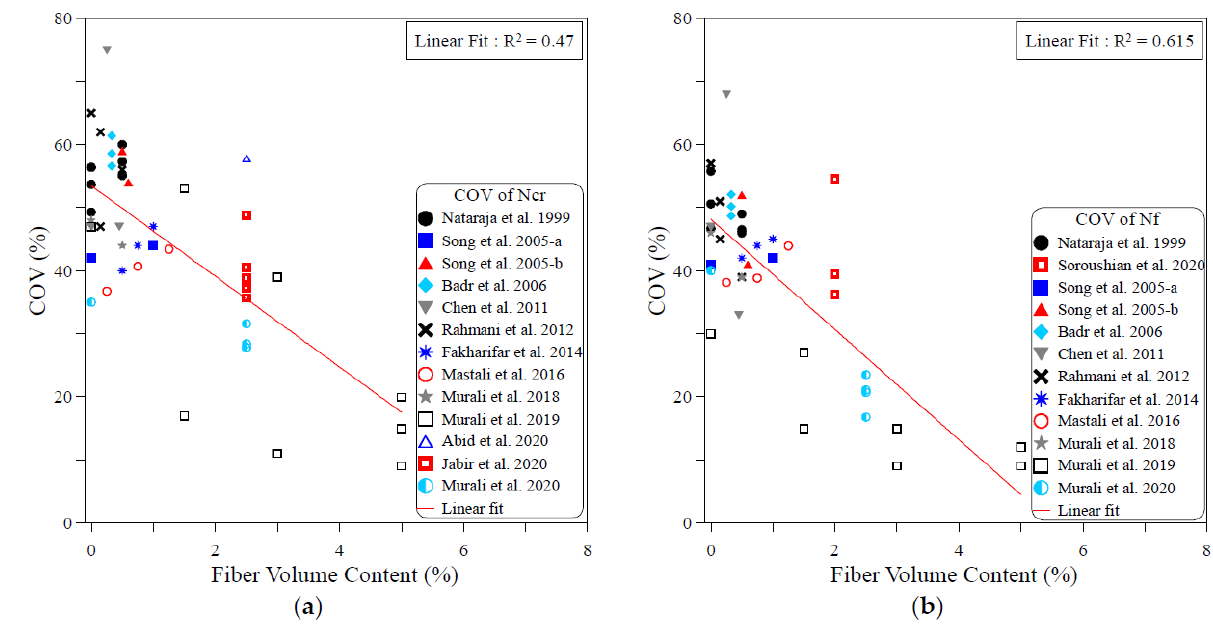
Figure 5. Effect of water–binder ratio on the scattering of impact results at ( a ) cracking and ( b ) failure.